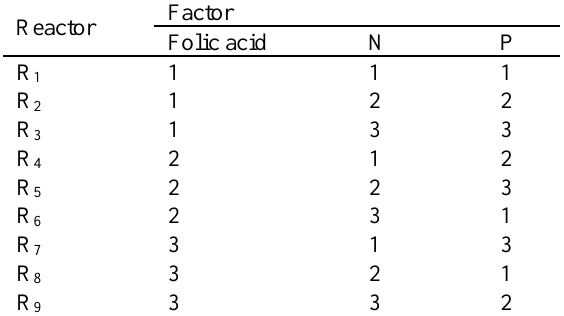
Table 4. Experiment design as Taguchi in L 9 orthogonal